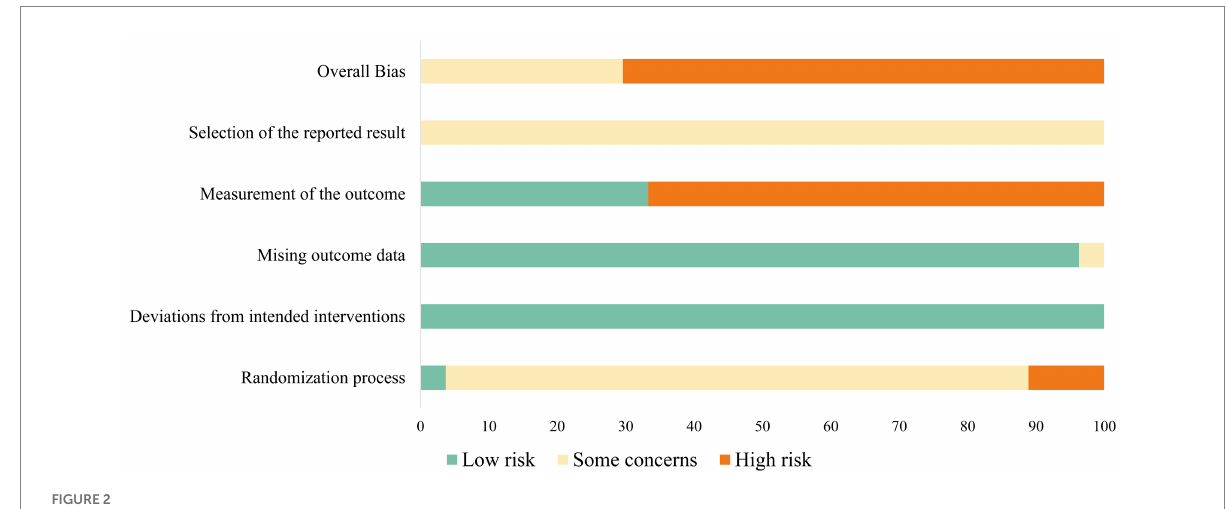
FIGURE 2 Cochrane risk of Bias 2.0